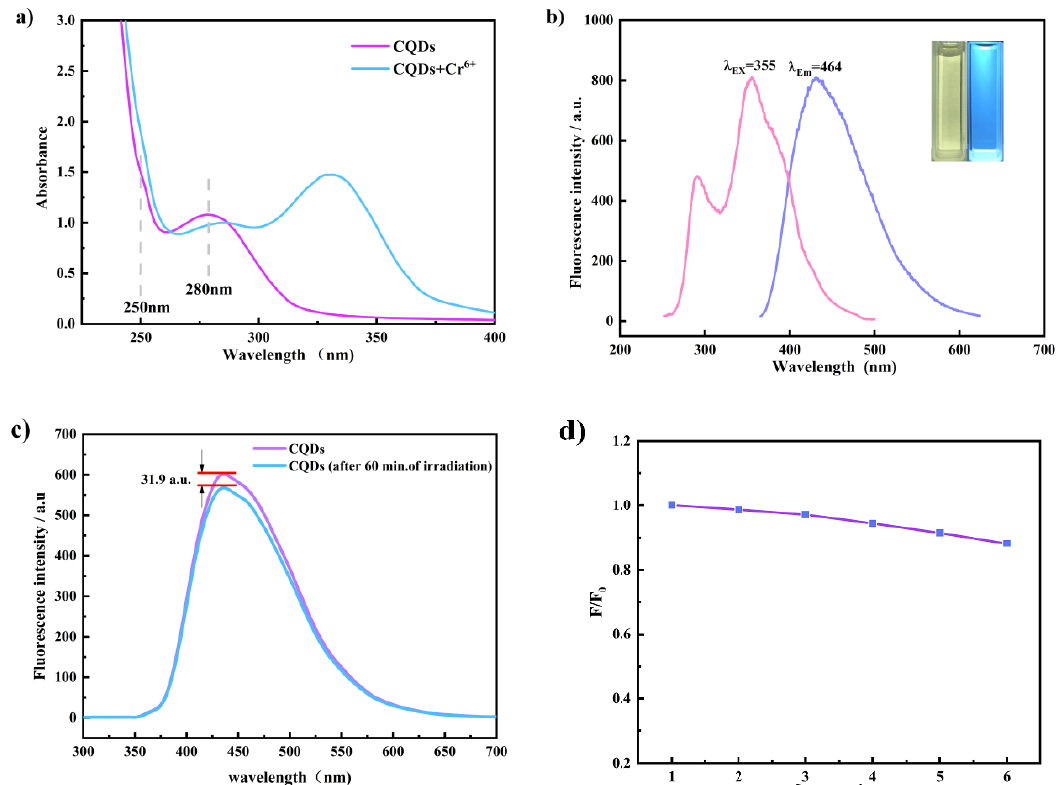
Figure 1. ( a ) The UV–Vis absorption spectrum of Si,N-CQDs in the absence and presence of Cr(VI). ( b ) The excitation and emission spectrum of Si,N-CQDs (insets show the corresponding colors under daylight and a 355 nm UV lamp). ( c ) The fluorescent spectrum of Si,N-CQDs before and after UV lamp irradiation at 355 nm for 60 min. ( d ) The effect of storage time on the fluorescence intensity of Si,N-CQDs.